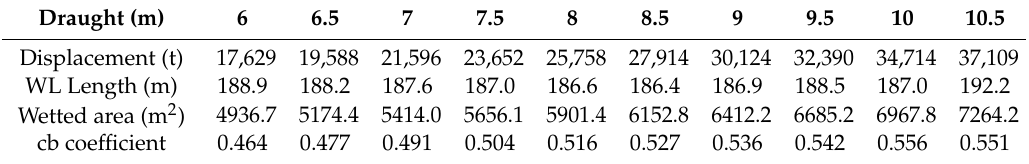
Table 3. Basic parameters of vessel form at design for maximum draft value cb = 0.55.